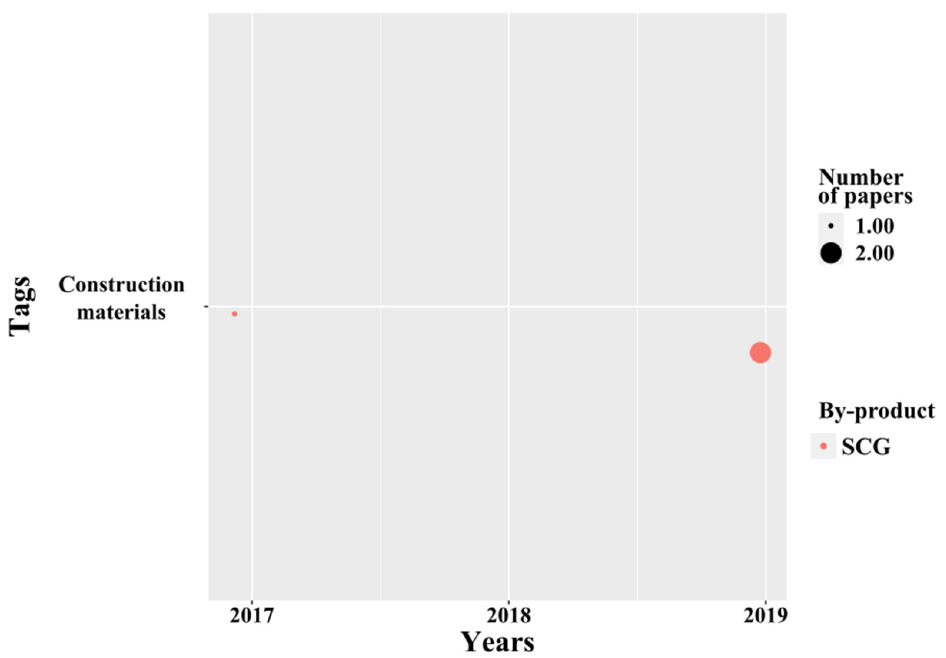
Figure 11. Temporal analysis of materials.